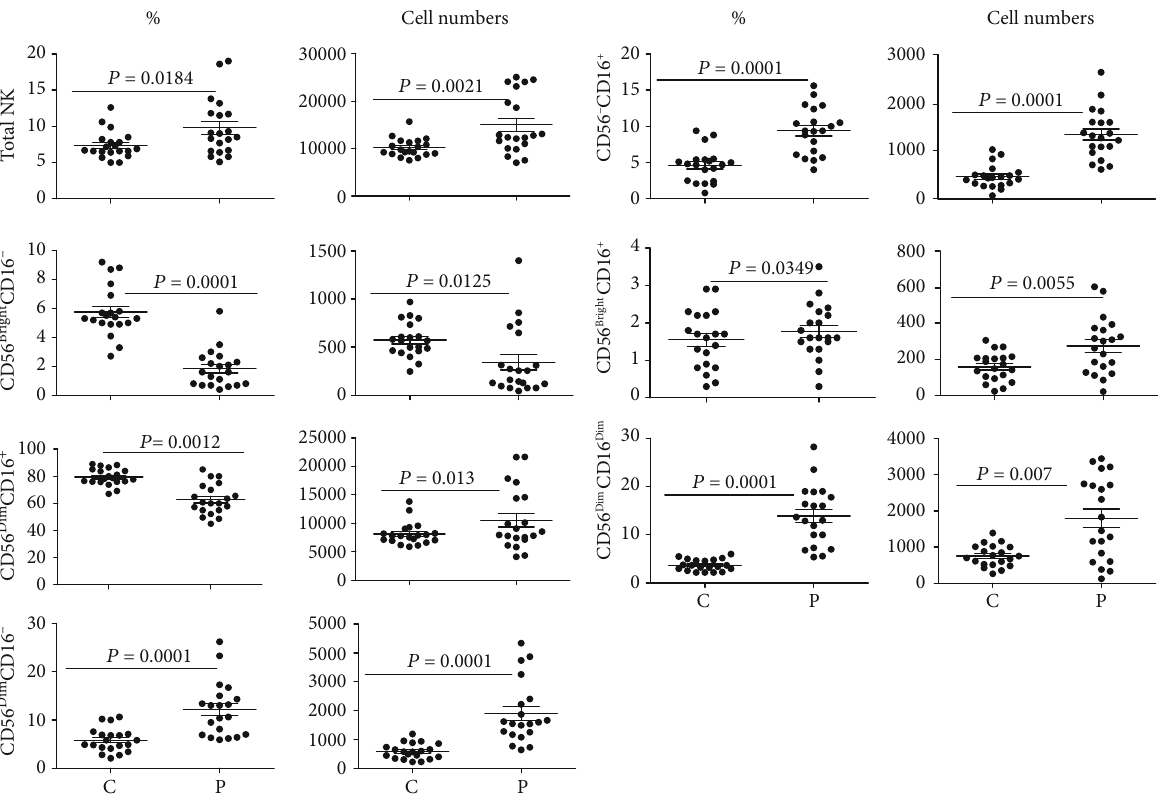
Figure 1: Percentages and absolute numbers of NK cells and their subsets. The fi gure shows percentages and absolute numbers (per ml) of the peripheral blood NK cells and their subsets (with respect to the expression of CD16 and CD56) in 20 CD patients (P) vis-à-vis 20 healthy control subjects (C). The fi gure shows means ± SE , individual data points, and p